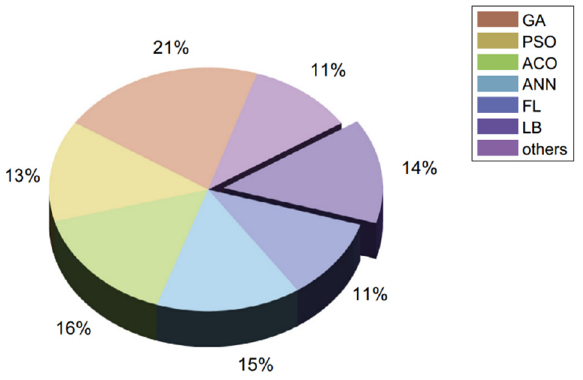
Figure 2. Classification of CI methods in UAV path planning by algorithm [61].